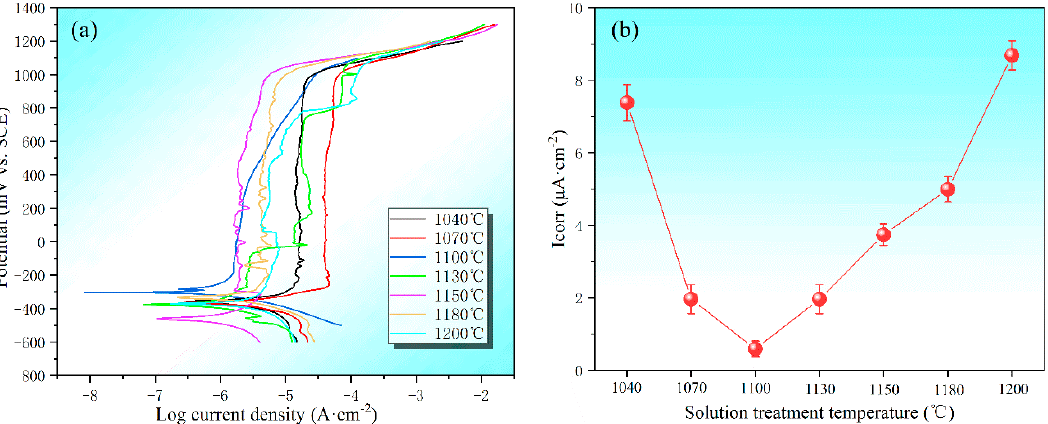
Figure 10. Potentiodynamic anodic polarization curves ( a ) and corrosion current densities ( b ) of the specimens after solution treatment at different temperatures.